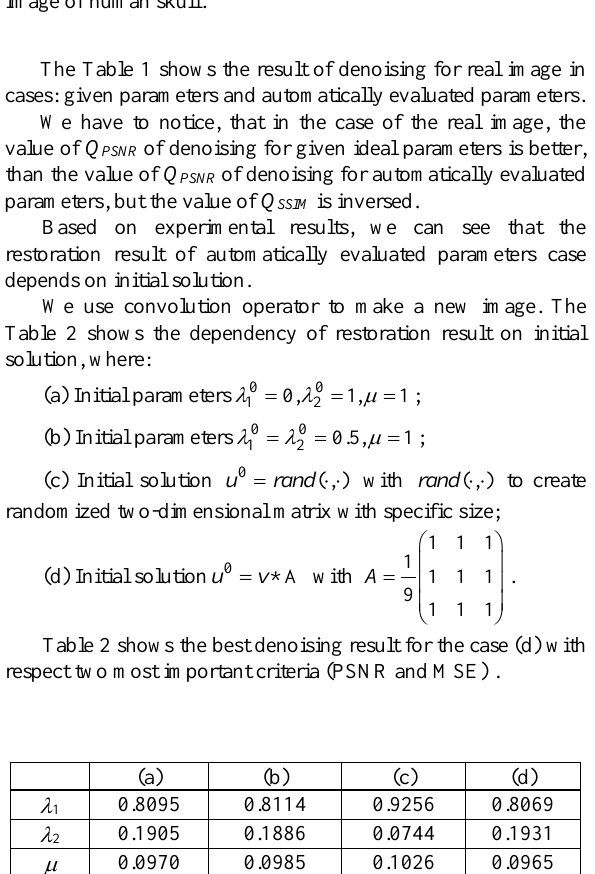
Table 1. Quality comparison of noise removal methods for real image of human skull.